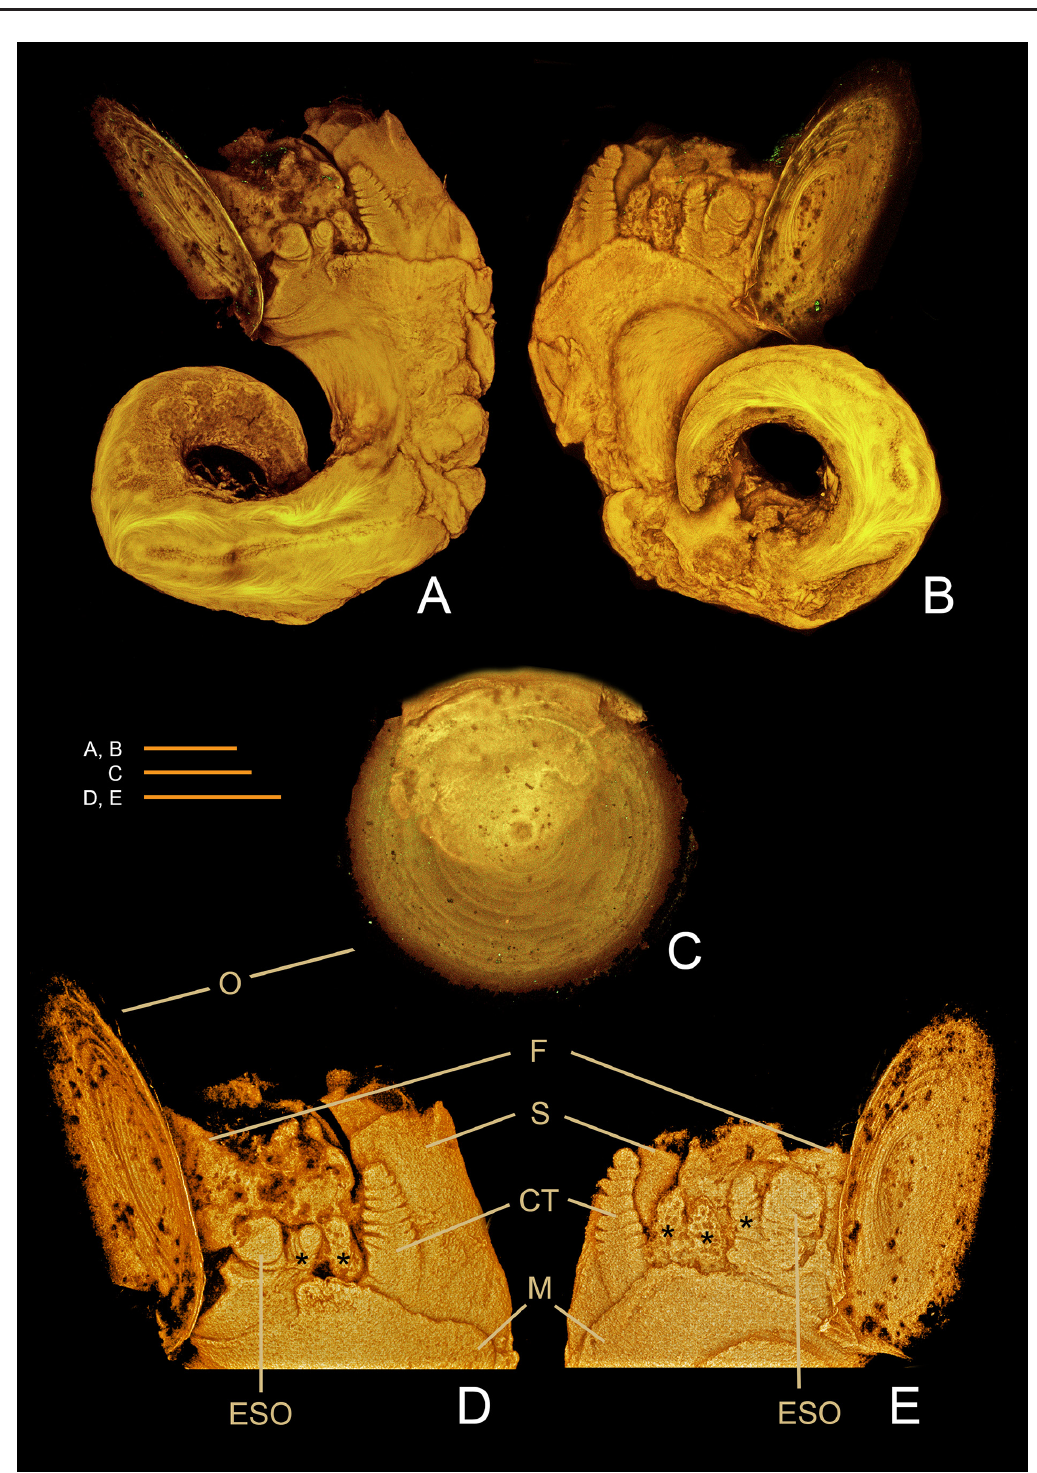
Fig. 4. CLSM images of contracted soft parts of Anatoma discapex sp. nov., Central Indian Ridge, INDEX19_042RO, (I19_Ma_83). A–B . Complete soft parts in basal and left anterior view (A) and apical and right-anterior view (B). C . External view of operculum. D . Left anterior view showing cephalic tentacle (CT), epipodial sensory organ (ESO), epipodial appendage (*), foot (F), operculum (O), mantle edge (M) and snout (S). E . Right view of anterior with same parts as in D. Scale bars: A–B = 0.2 mm; C = 0.15 mm; D–E = 0.4